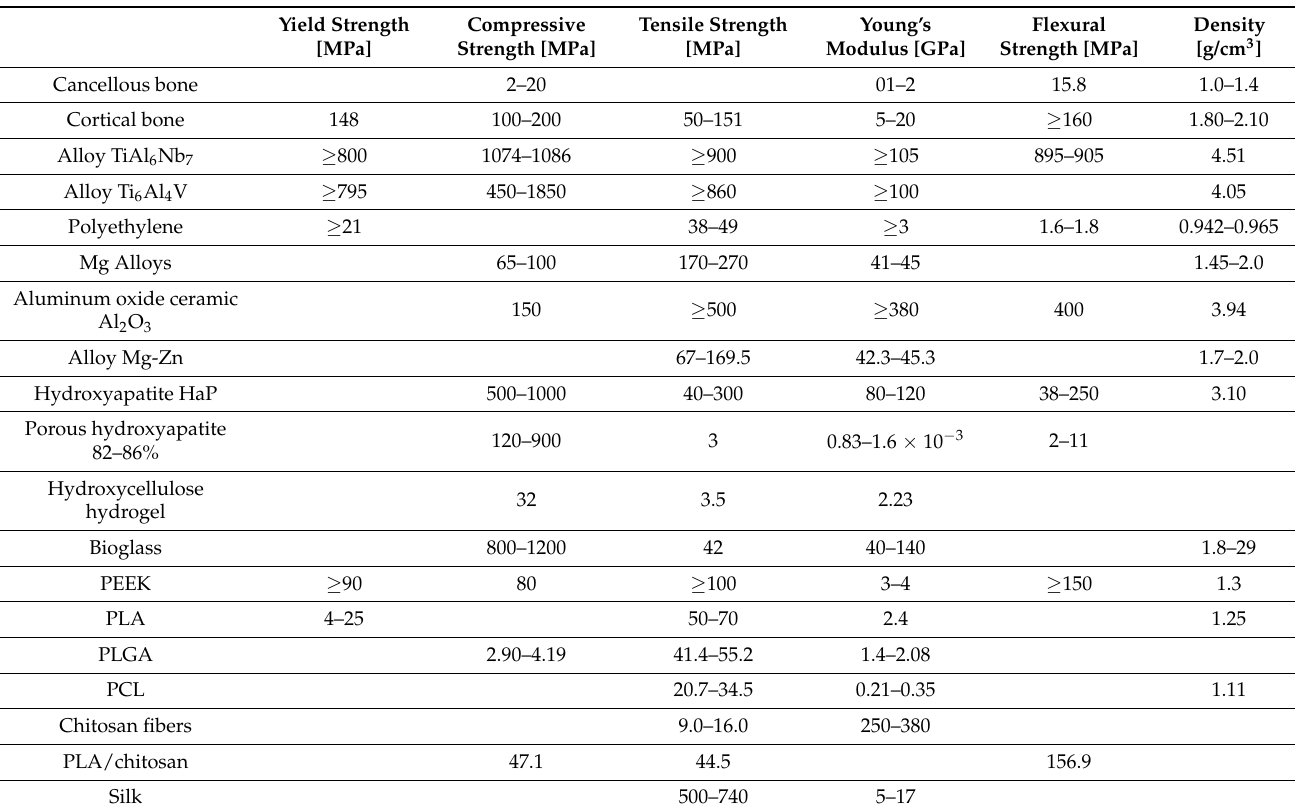
Table 2. Comparison of physicochemical properties of selected biomaterials used in bone tissue